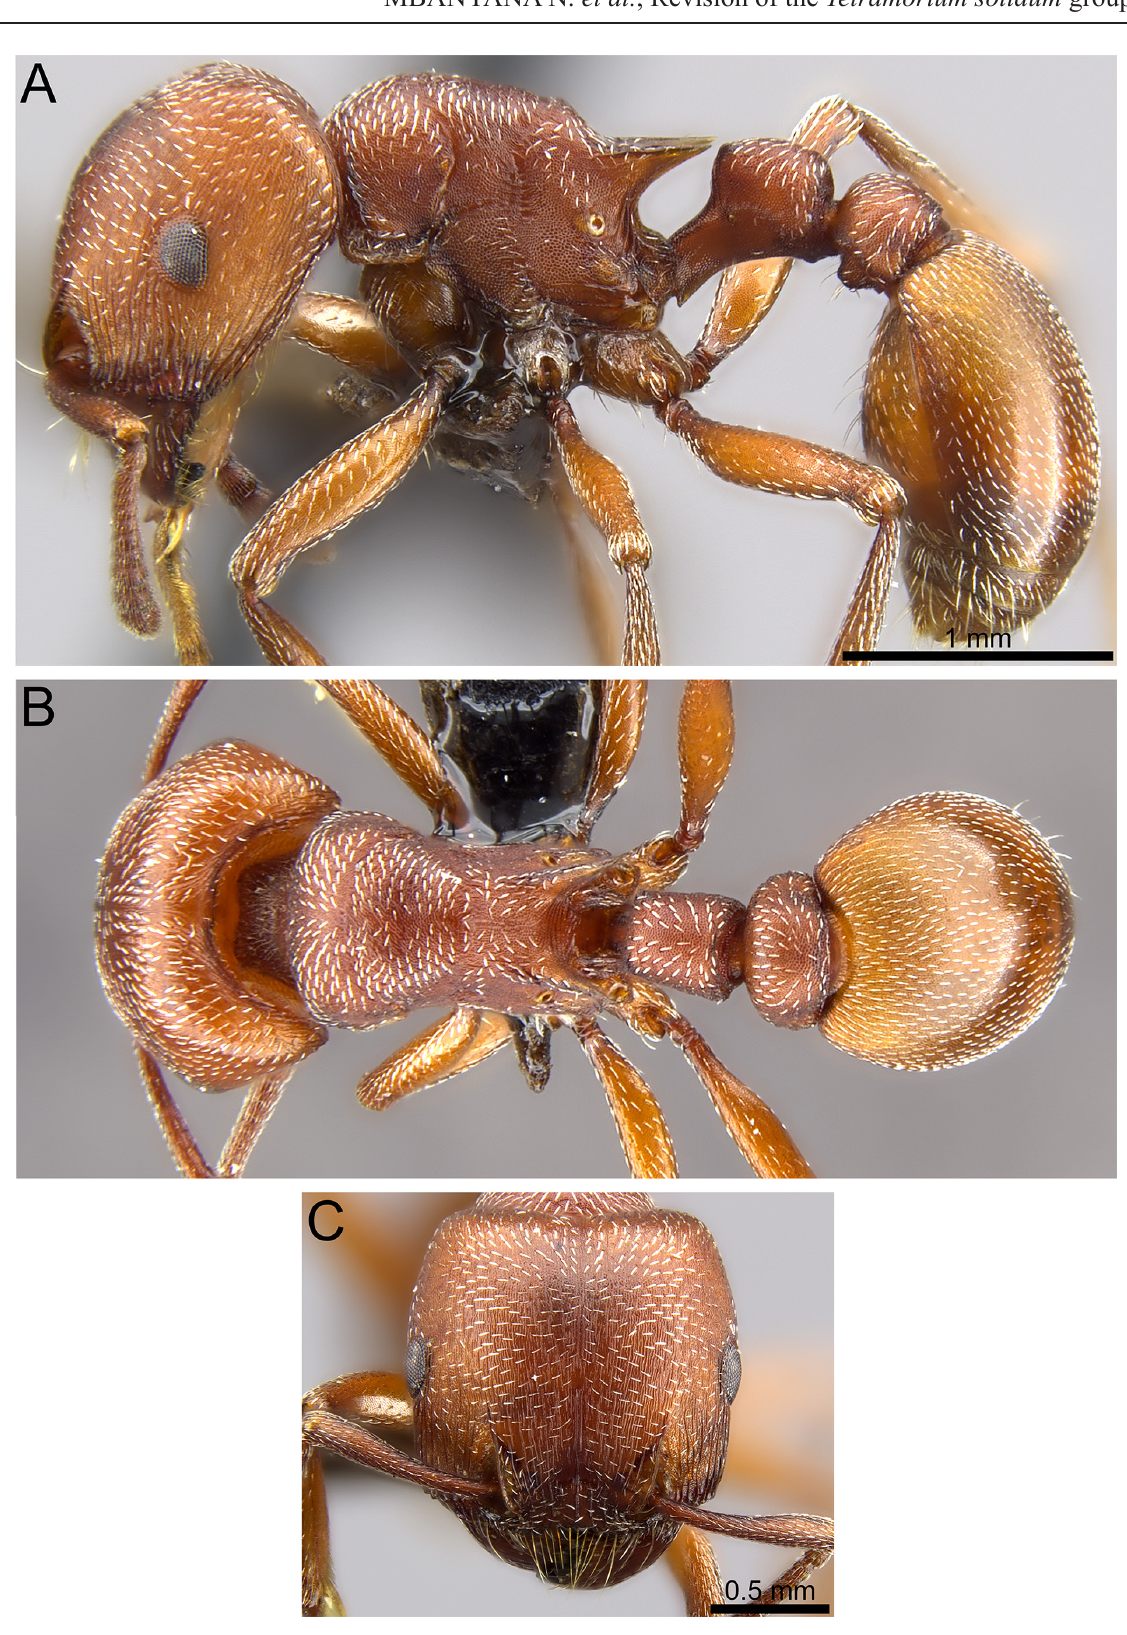
Fig. 21. Tetramorium setuliferum Emery, 1895 (MCZ_ENT00512567). A . Body in profile. B . Body in dorsal view. C . Head in full-face